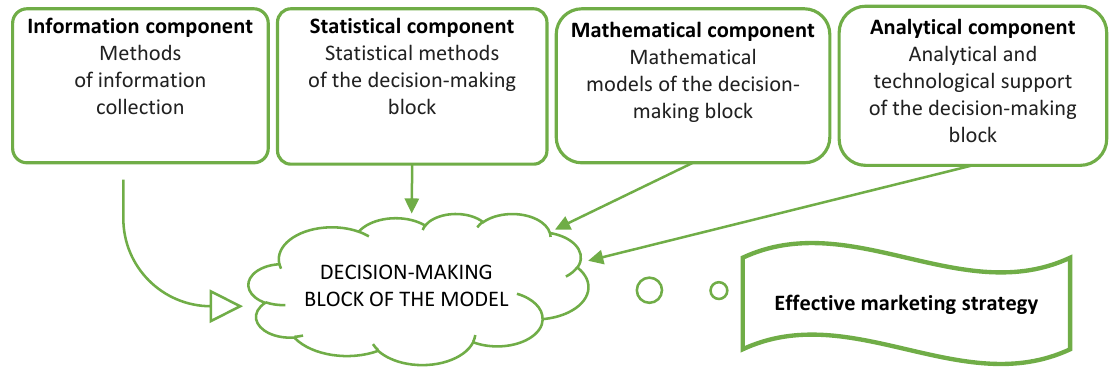
Figure 1. The conceptual scheme of the effective marketing strategy